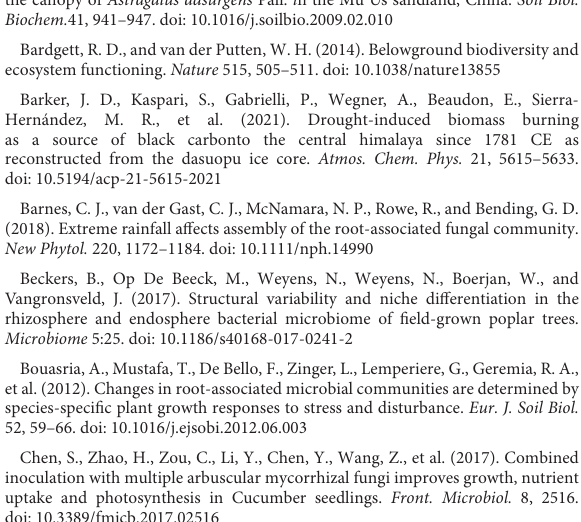
of Sarocladium kiliense and Monosporascus sp.; ASM, combination inoculation of the three species. SUPPLEMENTARYFIGURE5 Comparison of plant height under well-irrigated water and drought treatment when fungi were inoculated alone. Different lowercase letters indicate significant differences ( p < 0.05). C, non-inoculated control; A, inoculation with Alternaria chlamydospora ; S, inoculation with Sarocladium kiliense ; M, inoculation with Monosporascus sp.; WW, well-irrigated water; DS, drought stress. SUPPLEMENTARYTABLE1 Pearson’s correlation coefficients ( R values) between soil factors and fungal microbial community as well as the plant growth